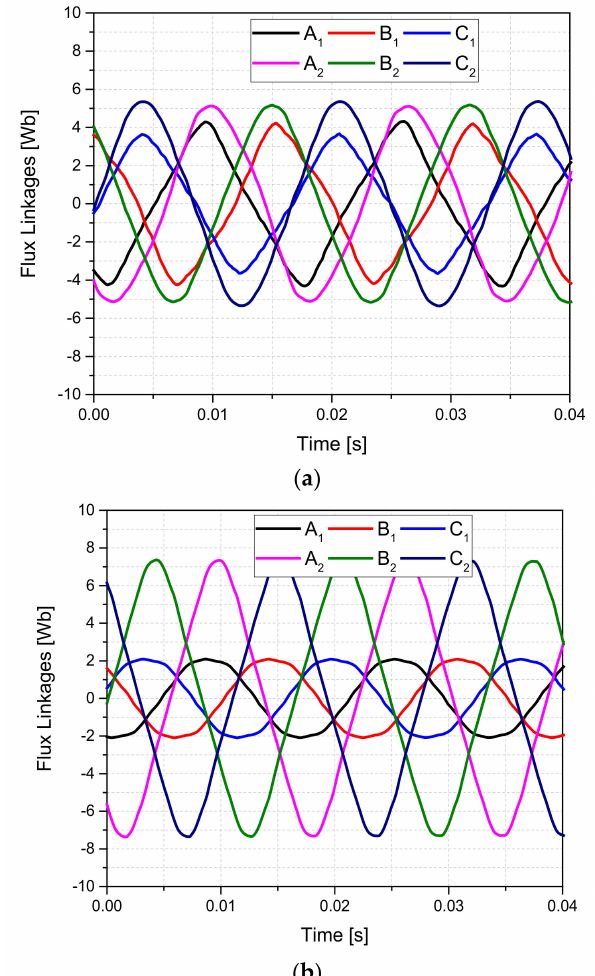
Figure 8. Flux linkages for ( a ) customary, and ( b ) proposed BL-WRSM topologies based on sub- harmonic field-excitation technique.